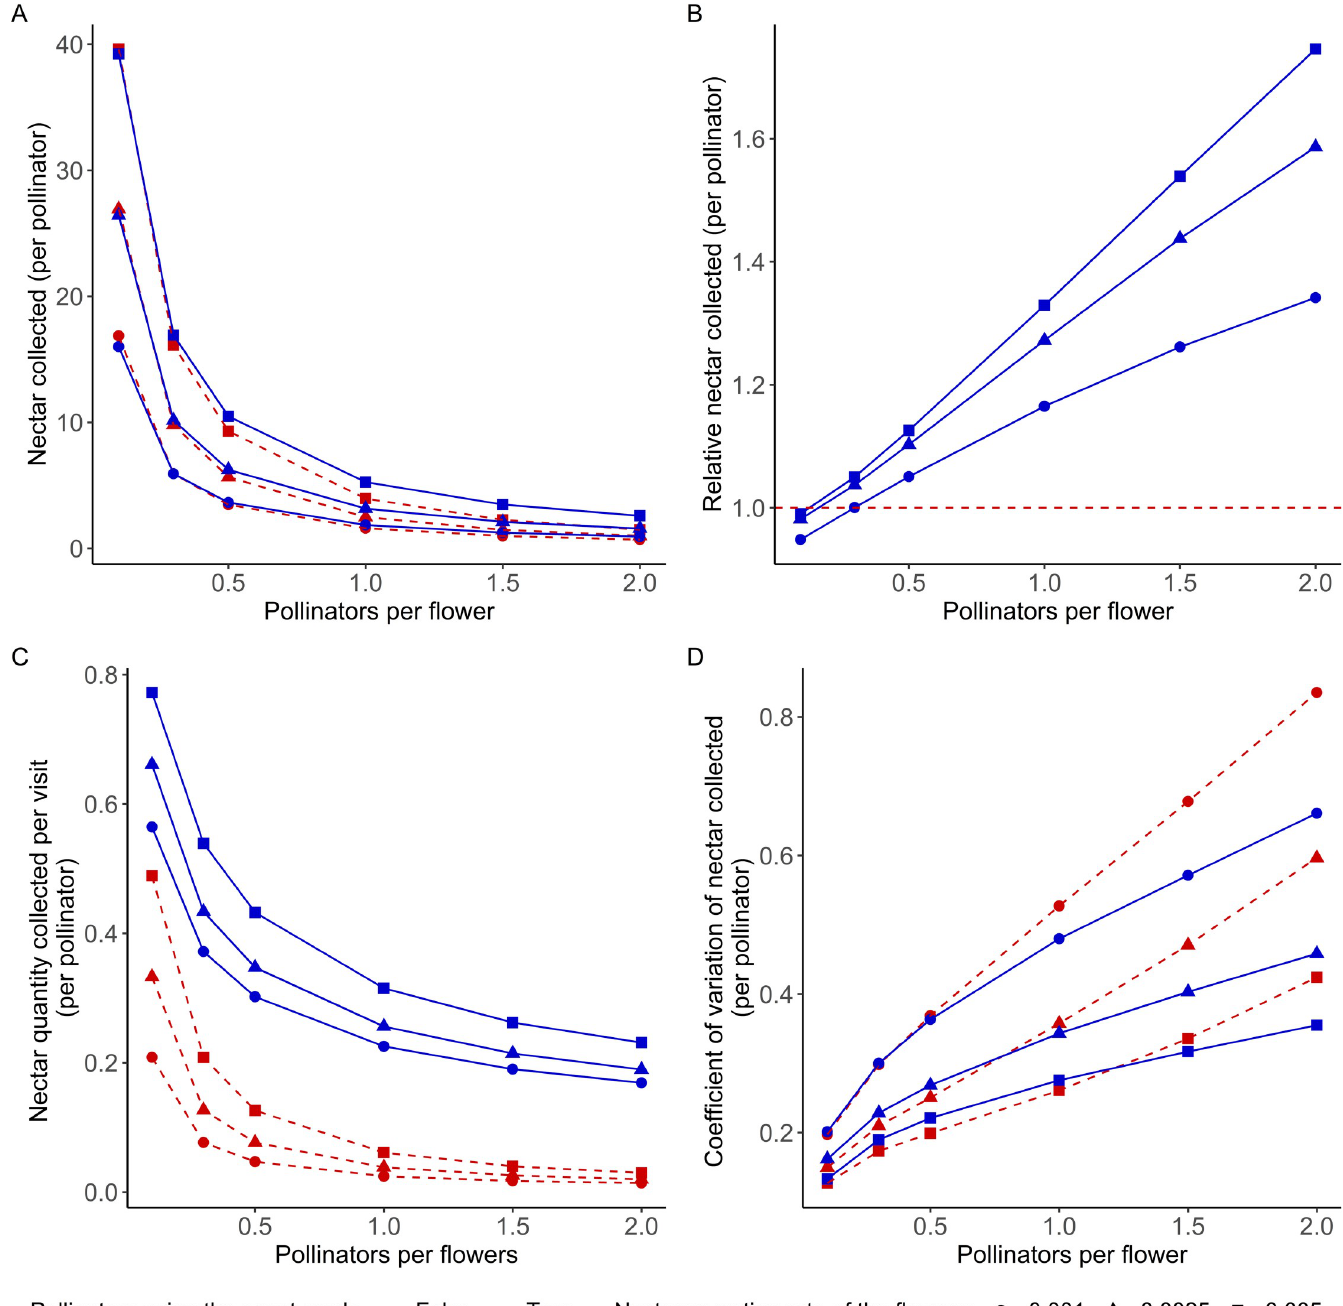
Fig 4. Pollinators foraging efficiency as a function of scent mark use and pollinators’ relative abundance (here measured in relation to the number of flowers, i.e., pollinators per flower) (A) Mean amount of nectar collected by the pollinators during the simulation. (B) Ratio between the amount of nectar collected by pollinators using the scent mark in relation to that collected by pollinators not using the scent mark. The red dashed line represents the threshold where the amount of nectar collected is equal for both strategies. (C) Mean amount of nectar collected by pollinators at each flower visit. (D) Coefficient of variation of the mean amount of nectar collected by pollinators during the simulation. In each figure, the x-axis represents the relative abundance of pollinators compared to flowers.